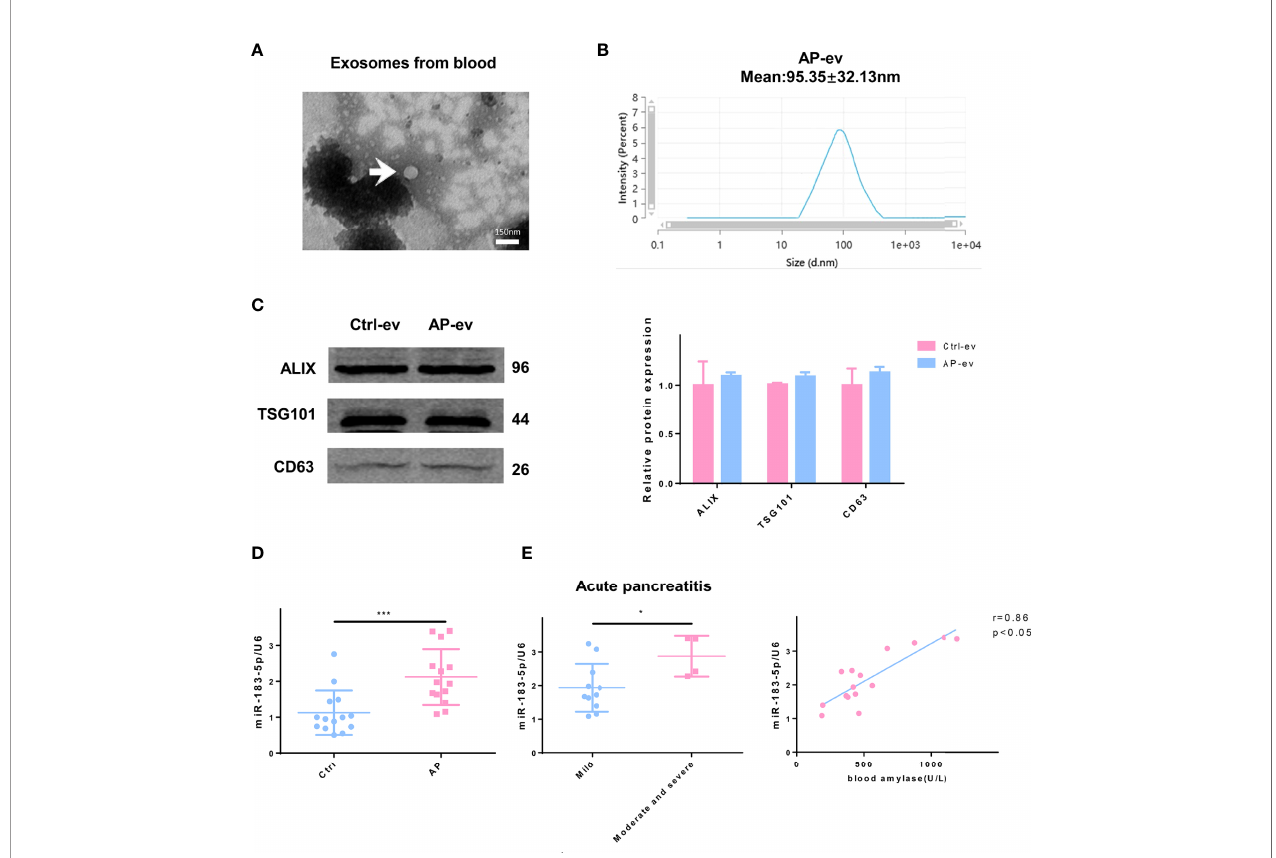
FIGURE 8 | Higher EV miR-183-5p levels in blood from patients with AP positively correlate with disease severity. (A) Representative electron micrograph of EVs puri fi ed from blood collected from patients with AP. EVs are labeled with white arrows. Scale bar, 150 m m. (B) NTA of the diameter of EVs in the blood of patients with AP. (C) Western blot analysis of the protein expression of EV markers (including Alix, TSG101 and CD63) in EVs isolated from blood. (D) The level of miR-183- 5p in EVs from blood of normal controls and patients with AP. (E) The level of miR-183-5p in EVs from blood of patients with mild and moderate-to-severe AP. Correlation analysis between miR-183-5p expression in blood EVs and blood amylase levels in patients with AP (r=0.86, p<0.05). All experiments were repeated three times. * p <0.05, ** p <0.01, *** p <0.001. Ctrl-ev: EVs from the serum of normal participants, AP-ev: EVs from the serum of patients with AP, mild group: patients with mild AP, moderate-to-severe group: patients with moderate or severe